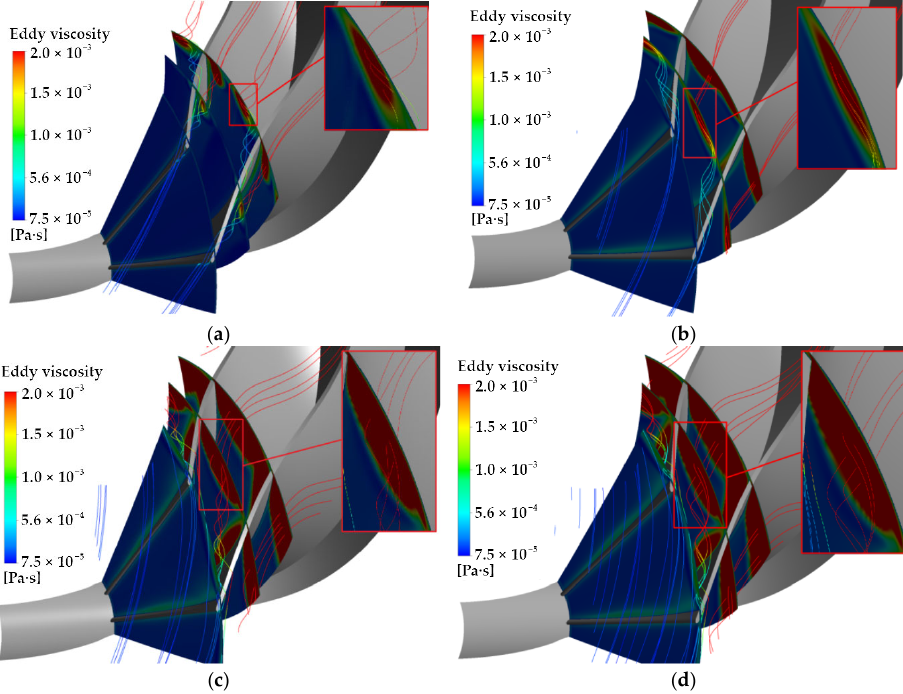
Figure 3. Cross ‐ sections of the TLVs under different working conditions. ( a ) S1: large margin point;